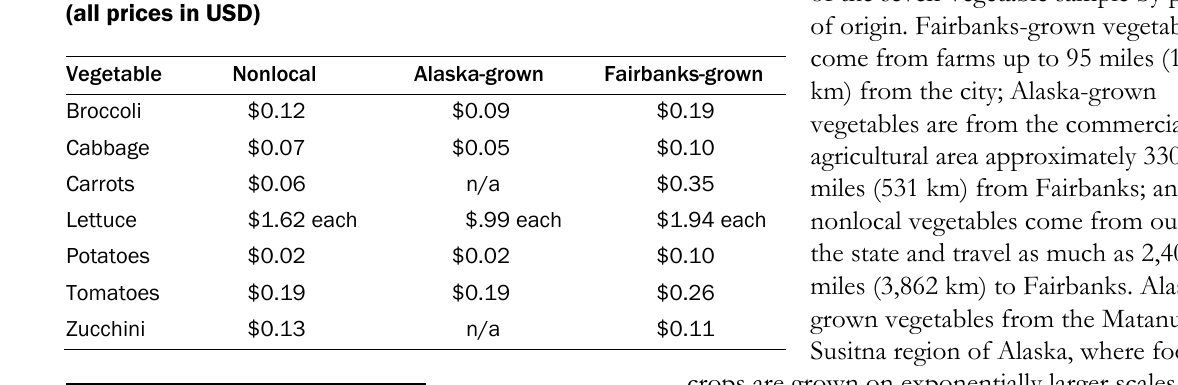
Table 4. Vegetable Costs (per ounce), June–July 2007 in the